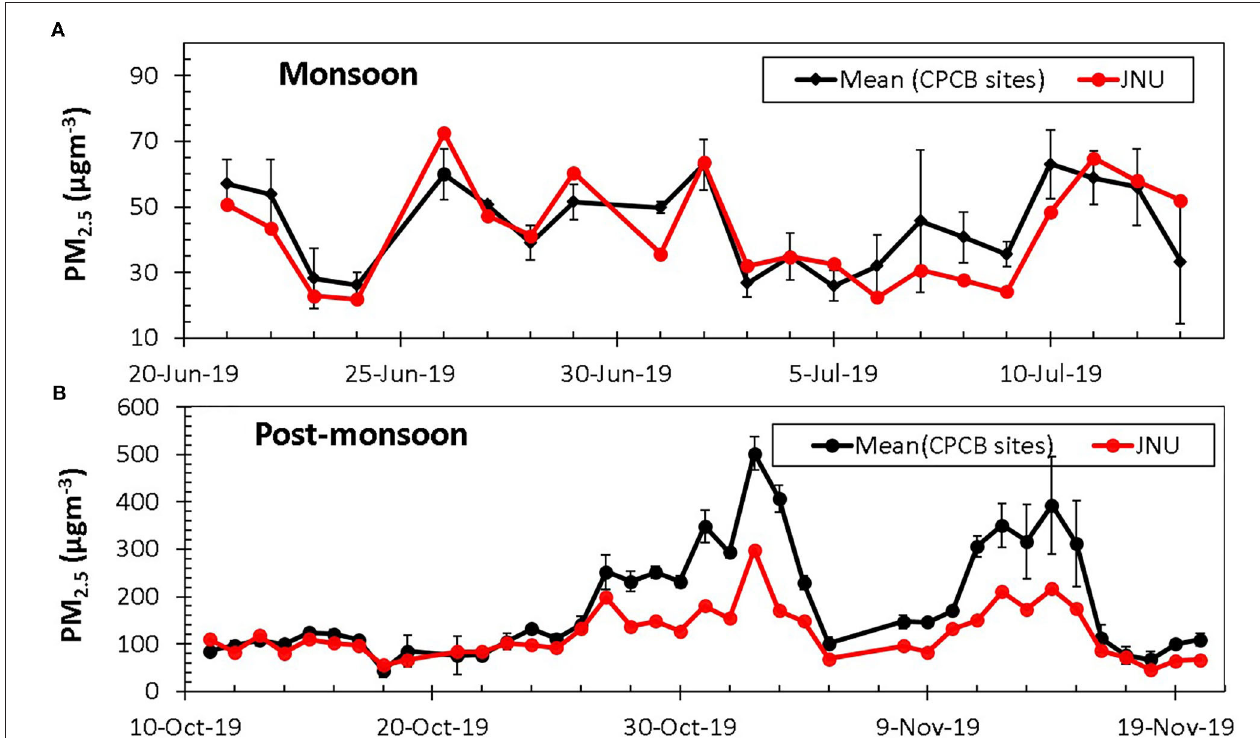
FIGURE 2 | Temporal variation of PM 2.5 concentrations ( µ g m − 3 ) at JNU (sampling site, shown by red color) and mean PM 2.5 concentrations for four CPCB sites (shown by black color, standard deviation is shown by vertical black lines) during (A) monsoon (21 Jun − 13 July 2019) and (B) post-monsoon (11 Oct − 20 Nov 2019)